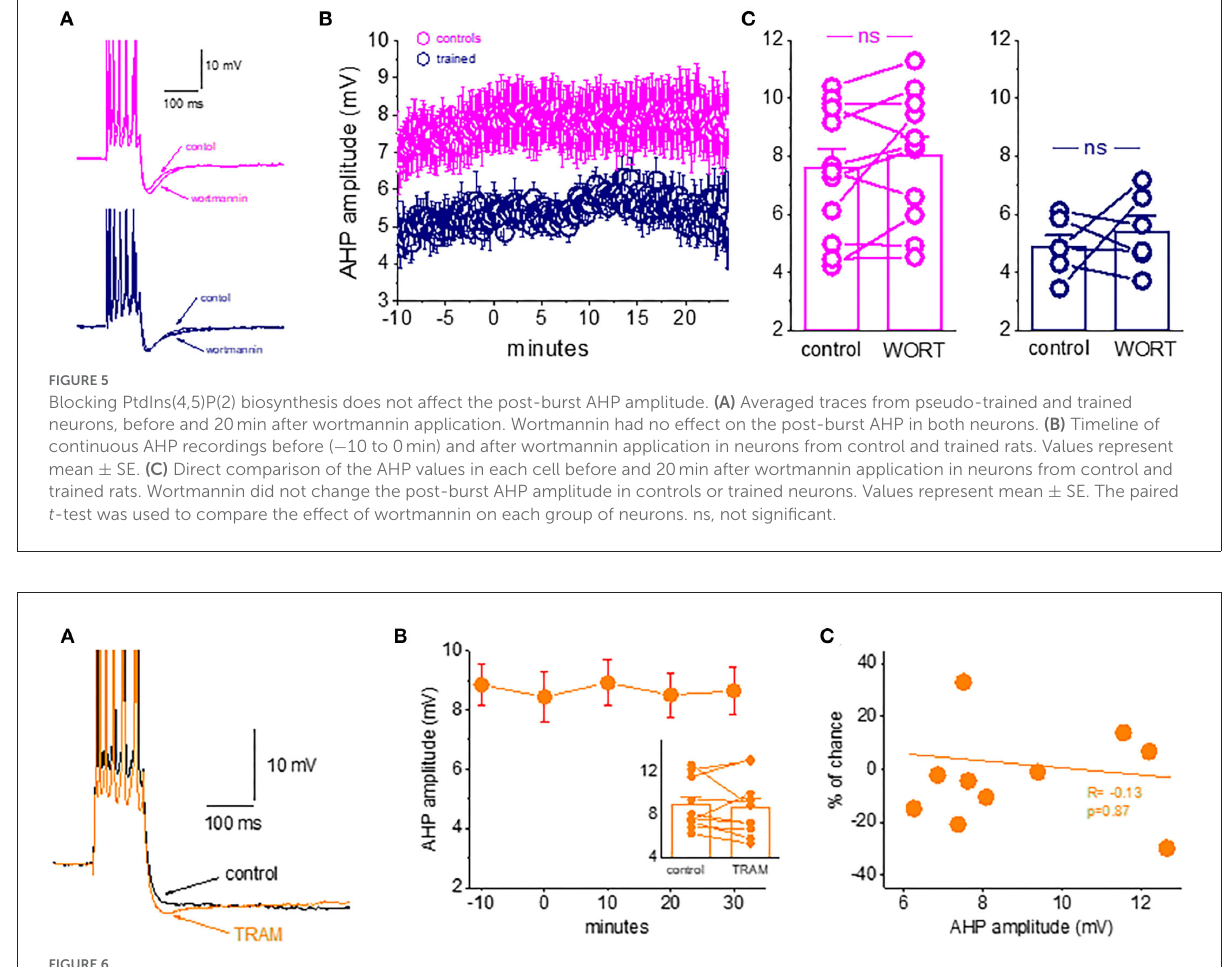
FIGURE6 Blocking the IKCa channels does not affect the post-burst AHP amplitude. (A) Averaged traces from a naive neuron before and 30min after TRAM-34 application. The IKCa blocker had no effect on the post-burst AHP. (B) Timeline of continuous AHP recordings before ( − 10 to 0min) and after TRAM-34 application in neurons from control and trained rats. Values represent mean ± SE. Inset : Direct comparison of the AHP values in each cell before and 30min after TRAM-34 application. Values represent mean ± SE. (C) The relation between the initial post-burst AHP amplitude and the effect of TRAM-34 in each neuron. TRAM-34 did not affect the AHP amplitude, regardless of its initial value ( r = − 0.13, p = 0.87). The paired t -test was used to compare the effect of